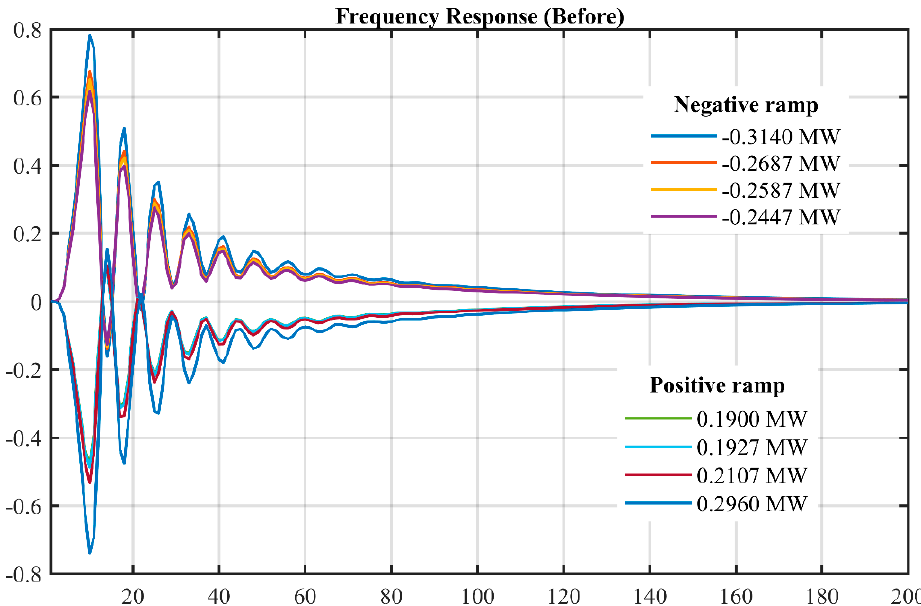
Figure 10. Transient response of the multi-machine power system without BESS.